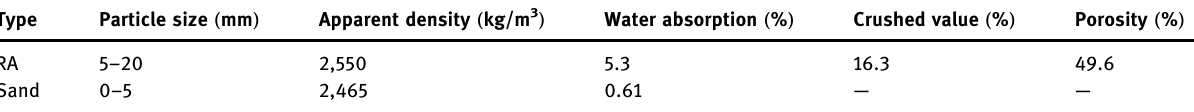
Table 1: Properties of RA and sand